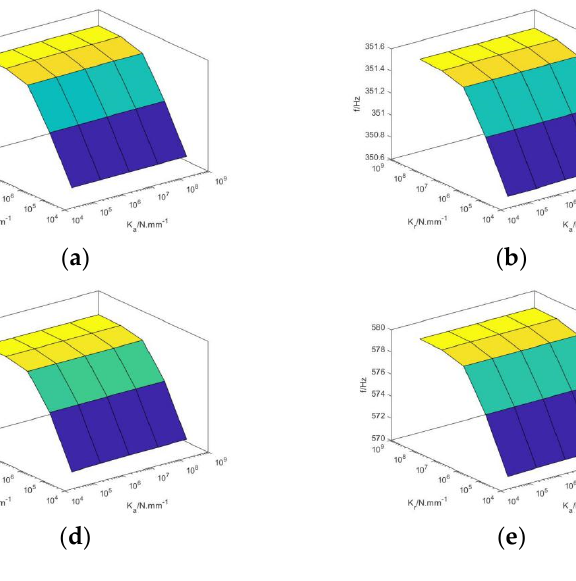
Figure 11. Variation of the first six-order natural frequencies of the rotary table with the bearing stiffness of the turntable; ( a ) Variation of first-order frequency; ( b ) Variation of second-order frequency; ( c ) Variation of third-order frequency; ( d ) Variation of fourth-order frequency; ( e ) Variation of fifth-order frequency; ( f ) Variation of sixth-order frequency.